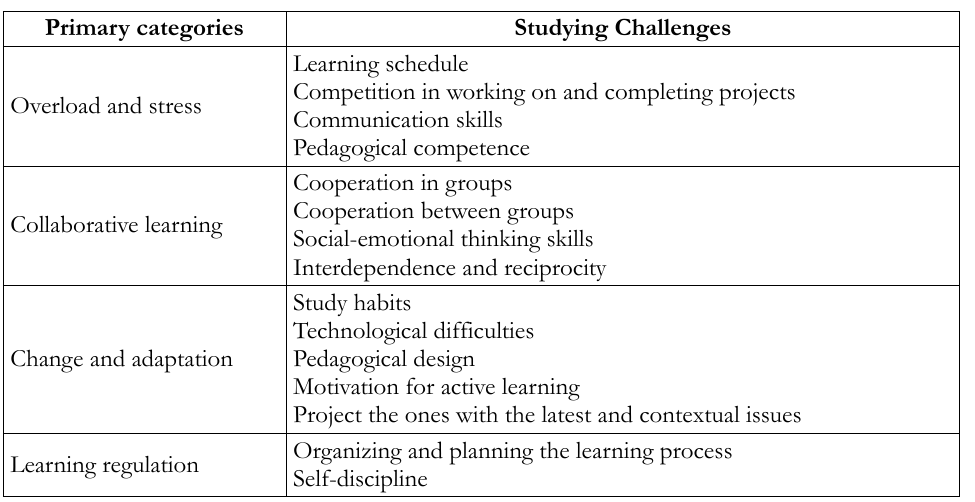
Table 2. Challenges for Literacy Project and the Pedagogical Competencies